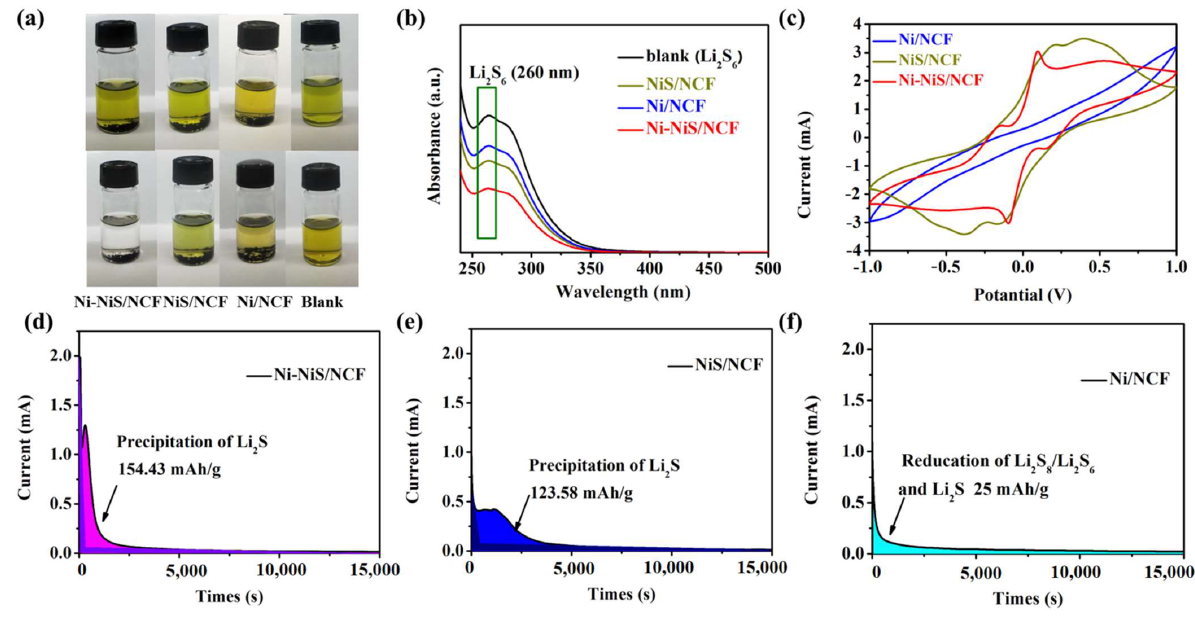
Figure 4. ( a ) Visual adsorption of Li 2 S 6 with different materials; ( b ) UV absorption profile after adsorption of Li 2 S 6 ; ( c ) the CV curves of symmetric cells with Ni-NiS /NCF, NiS/NCF, and Ni/NCF using Li 2 S 6 as electrolyte. Time – current – time curve of 2.05 V constant voltage discharge on Ni/NCF. ( d ) NI-NIS /NCF; ( e ) NiS/NCF; ( f ) Ni/NCF.